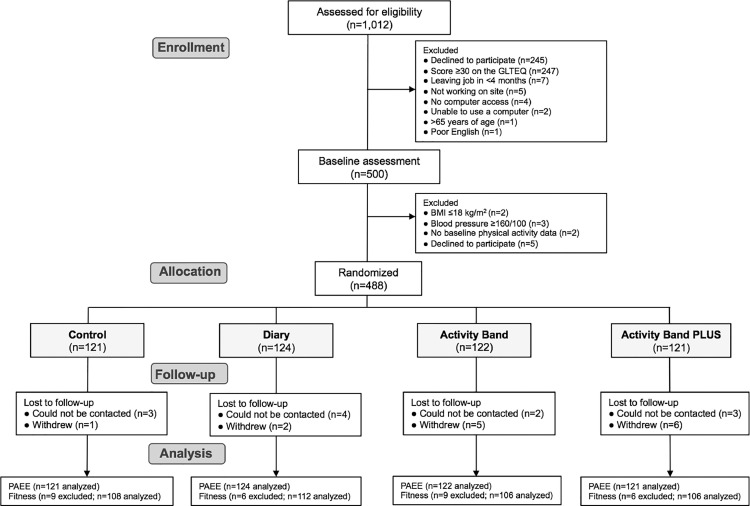
CONSORT flowchart.